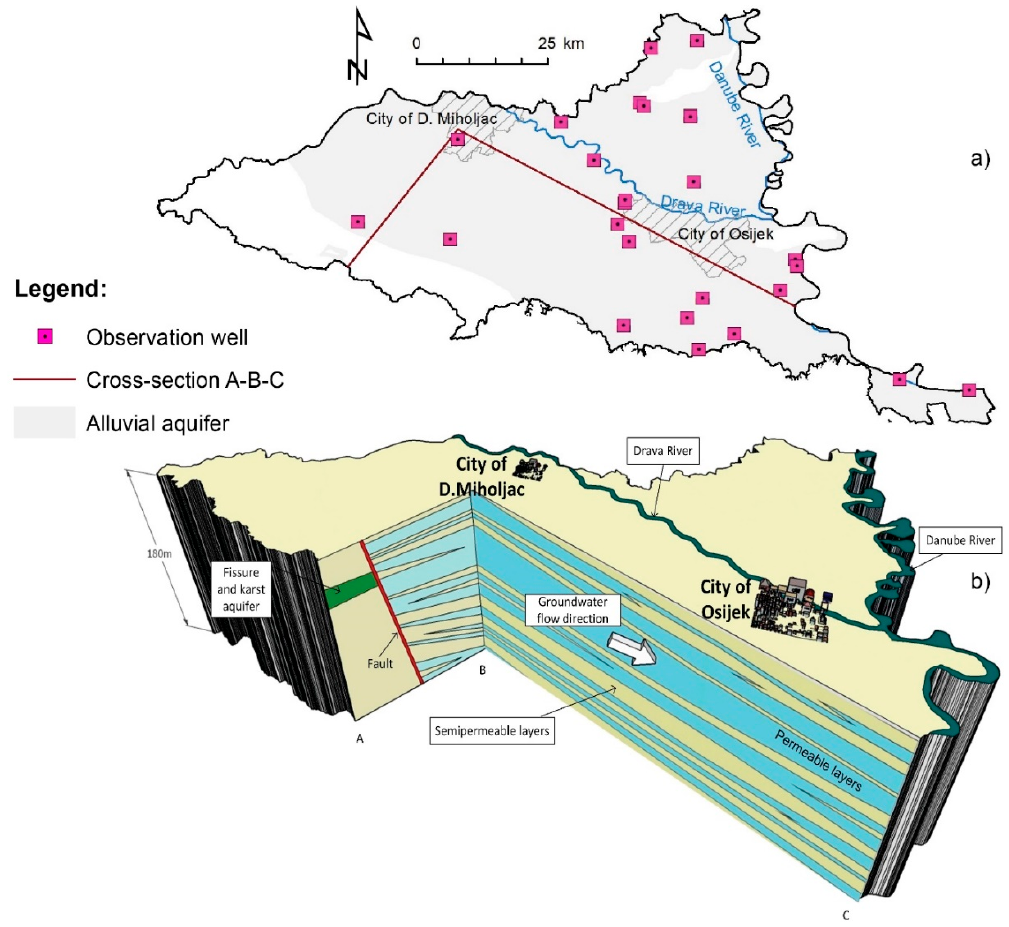
Figure 3. Conceptual model of the groundwater body CDGI_23: ( a ) Planar extent of the groundwater body; ( b ) Schematic 3D hydrogeological cross-section.